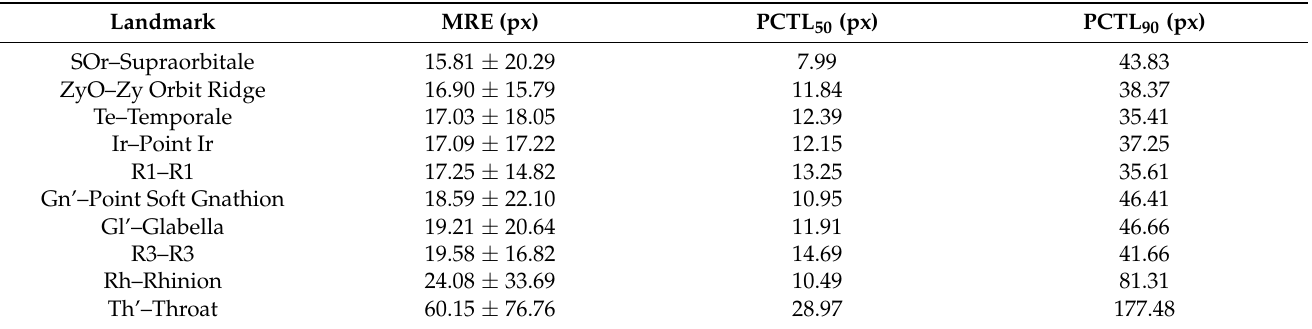
Table 9. Ten cephalometric landmarks from the AUDAX database detected least accurately by the SCN-EXT method. For denotations, see Table